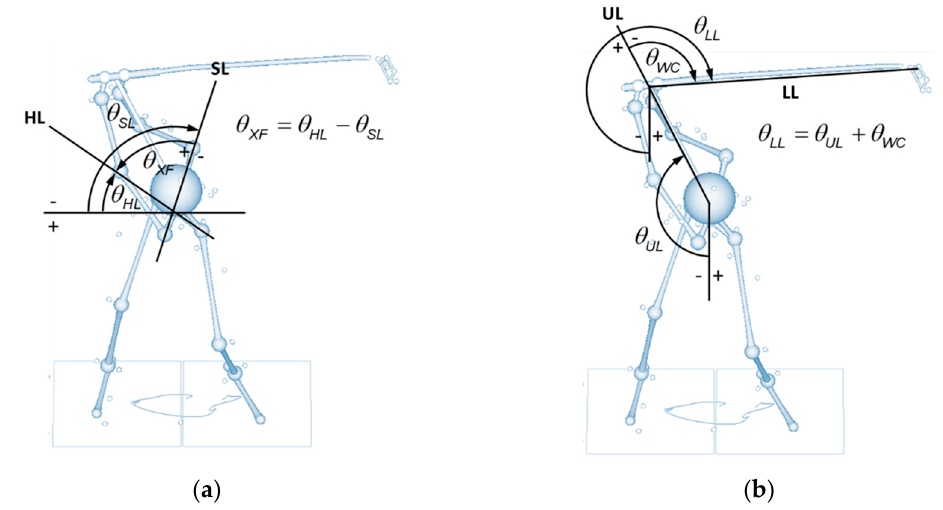
Figure 1. The on-plane angles of the axle-chain system defined on the functional swing plane. The hip line (HL) and shoulder line (SL) angles are relative to the horizontal line ( a ), while the upper lever (UL) and lower lever (LL; club) angles are relative to the vertical line (downward) ( b ). The wrist cock (WC) angle is the relative angular position of the LL to the UL. Counterclockwise angles yield positive values in these angles. The X-factor is the angle formed by the HL and the SL. A more backward-rotated (more negative) SL position relative to the HL yields a positive X-factor.